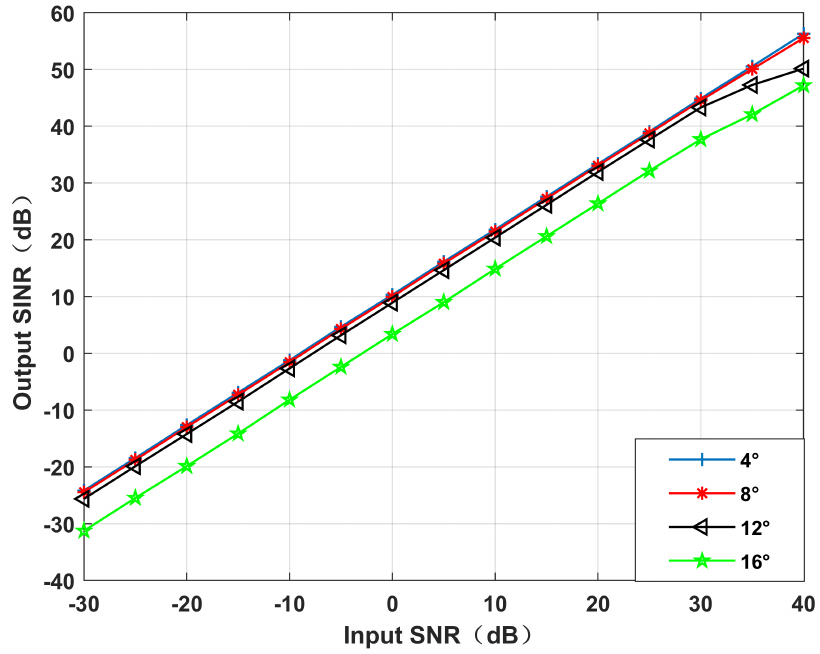
Figure 8. Output SINR versus the input SNR for different null broadening angles. Simulation